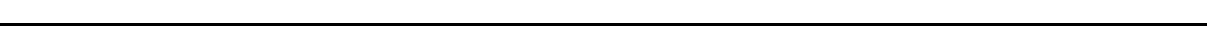
Fig. 2 Increased NOTCH activation facilitates EHT. a Schematic diagram of experiments. D4 HE cultured in presence of DAPT for 4 days (D4 + 4) or 1 day (D4 + 1), or DMSO (control). CD144 + endothelial and CD43 + blood cells were analyzed following 4 days of culture. b Flow cytometric